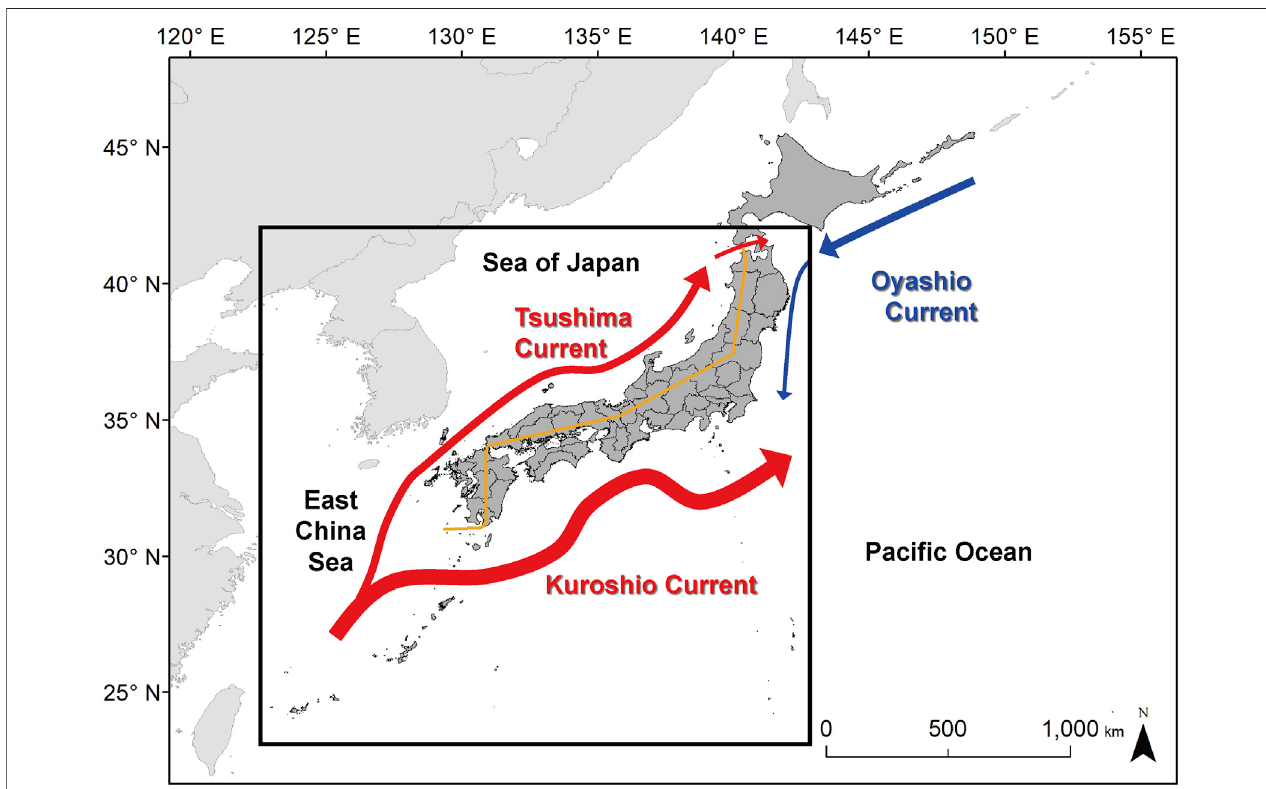
FIGURE 1 | Study area (outlined in bold) and major ocean currents around Japan. The warm currents are in red and the cold currents in blue. The ocean current data are based on Nishimura (1981). The orange line divides the coast of the Sea of Japan side and the coast of the Paci fi c Ocean.